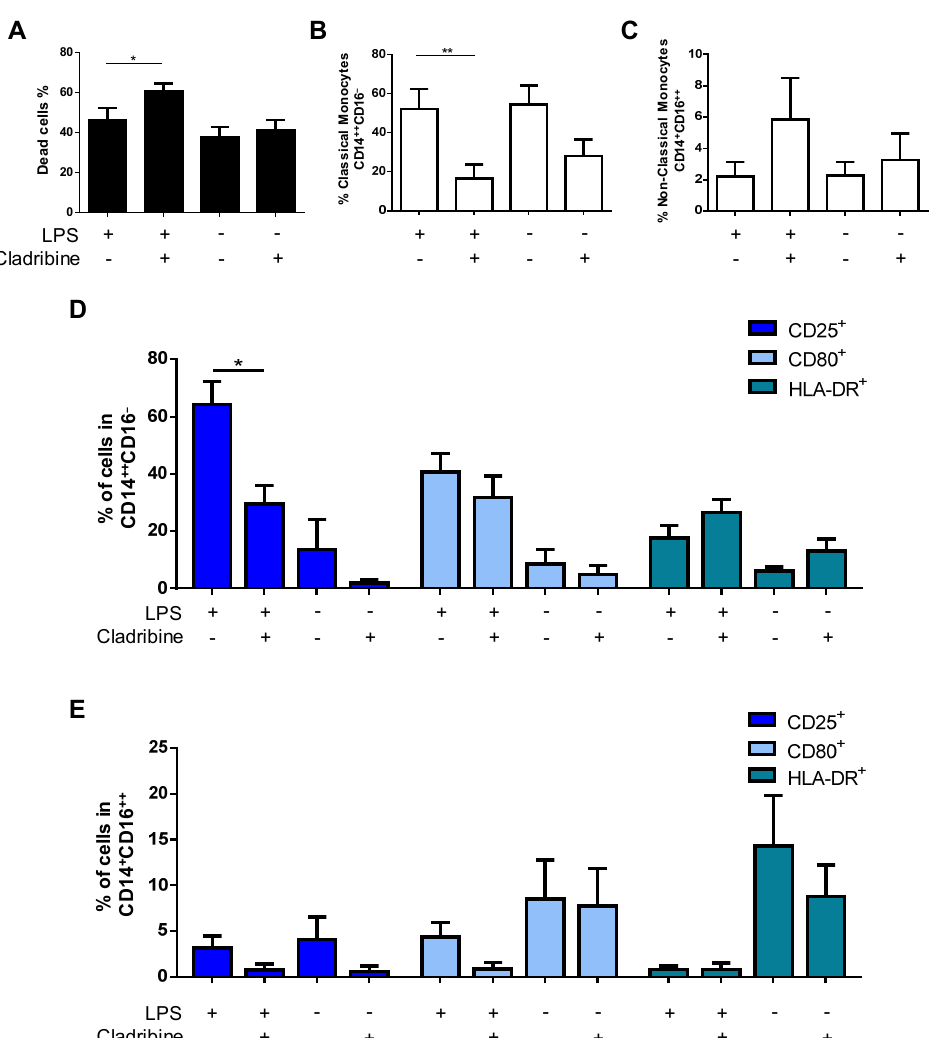
Figure 5. Effect of cladribine on the activation of monocytes. Purified monocytes were treated with 0.1 µ M cladribine for 24 h, in the absence or presence of LPS (100 ng/mL), and activation was assessed by flow cytometry, by means of immunostaining against surface activation markers in classical and non-classical monocytes. ( A ) Cell death of total CD14 + -monocytes was assessed by flow cytometry using a fixable viability dye. After selecting alive cells, monocytes were gated on classical and non-classical monocytes based on the expression of CD14 and CD16. The effect of cladribine in the percentage of ( B ) classical (CD14 ++ CD16 − ) and ( C ) non-classical (CD14 + CD16 ++ ) monocytes was evaluated. The effect of cladribine over monocyte activation determined in ( D ) classical, and ( E ) non- classical monocytes, is shown as the percentage of the corresponding monocyte phenotype expressing CD25, CD80, and HLA-DR. The gating strategy for this experiment is shown in Supplementary Figure S4. Mann–Whitney tests or Student’s t -tests were applied to compare the mean value of LPS + cladribine to a control mean (LPS group). * p -value < 0.05, ** p -value < 0.01. Data are expressed as the mean. Error bars represent the SEM, ( N = 5). LPS: